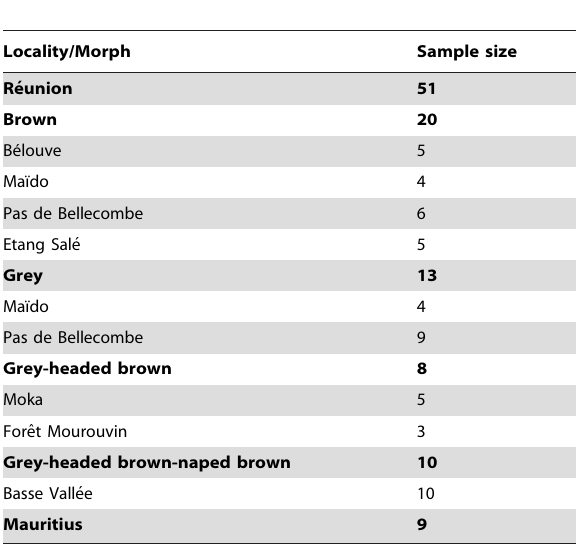
Table 2. Localities and number of birds sampled on the islands of Re´union and